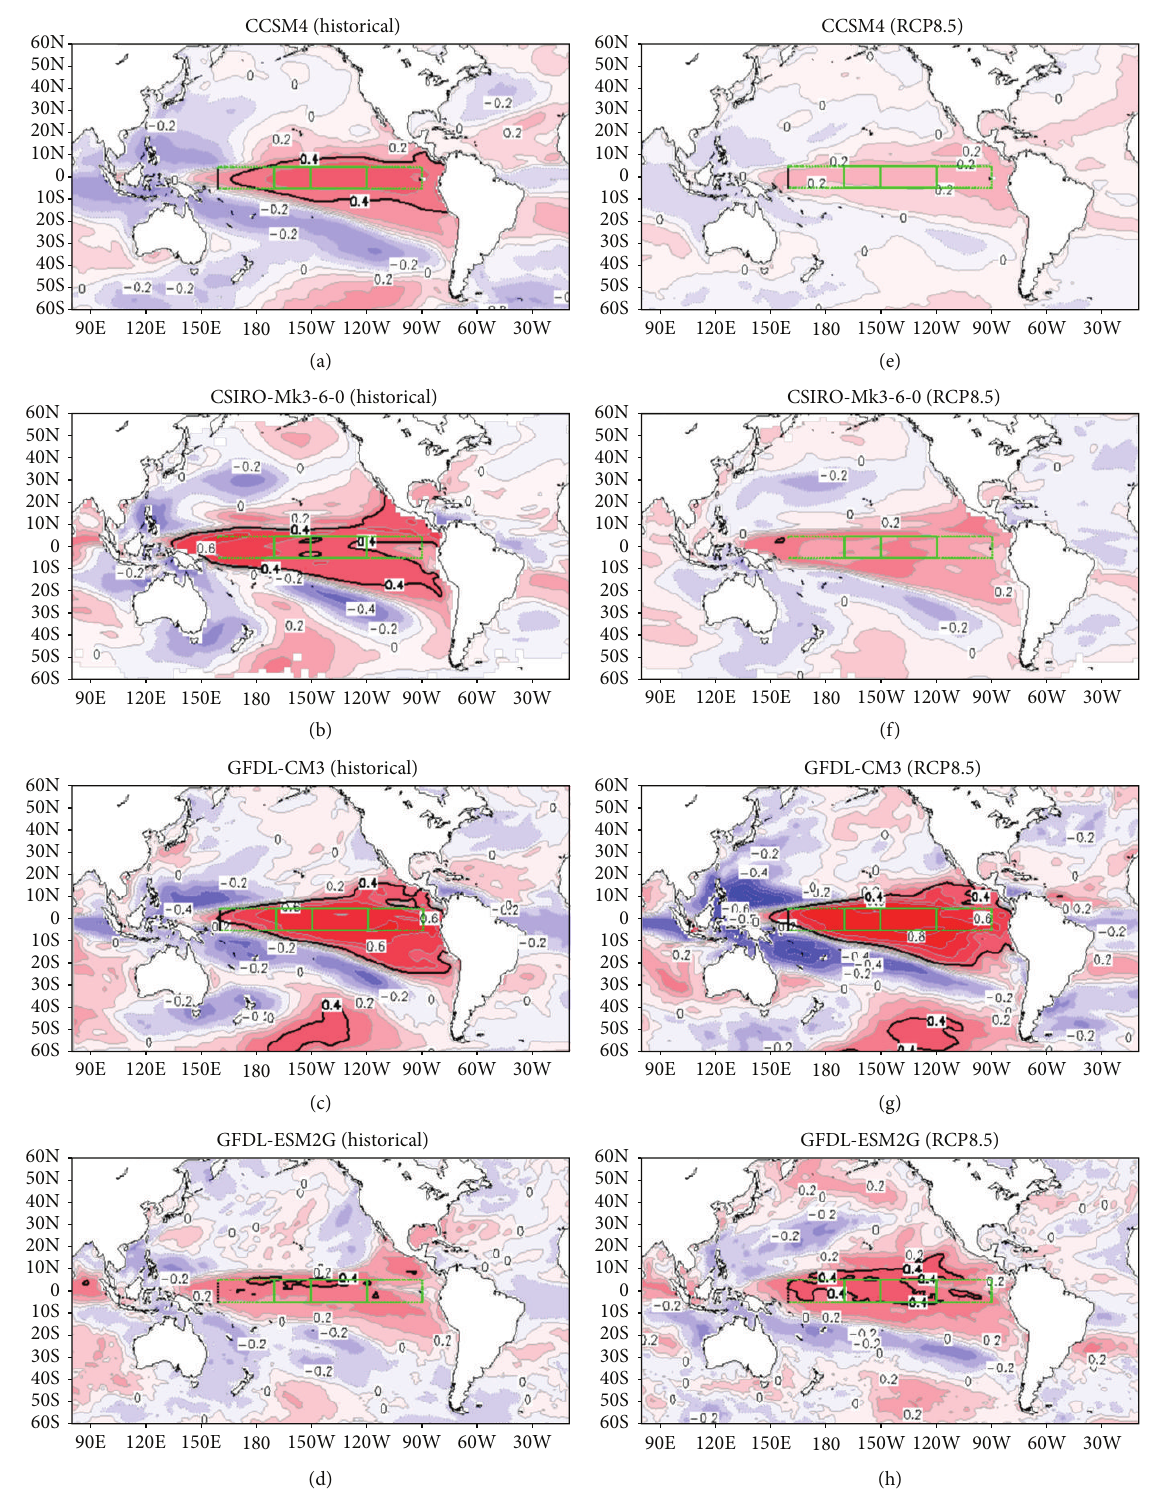
Figure 8: Ensemble member averaged correlation between the November SST and the DJF mean daily rainfall anomaly averaged over the SE US for CMIP5 models 1–4 (historical run: (a)–(d), RCP8.5 run: (e)–(h)). Locations of the Ni˜no 3, 3.4, and 4 regions are marked with rectangular box from left, middle, and right, respectively. The 0.4 contour is thickened for better